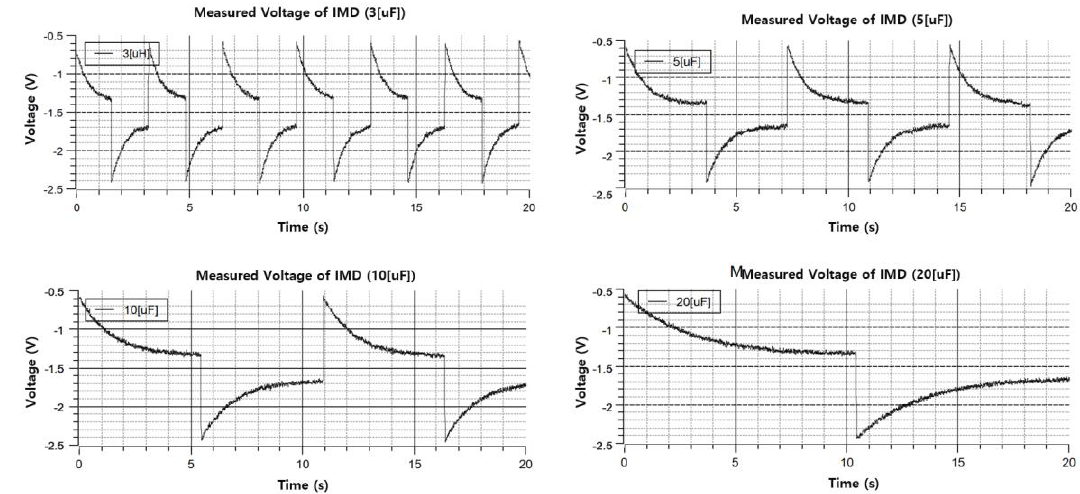
Figure 11. IMD measurement voltage of system applying proposed method.